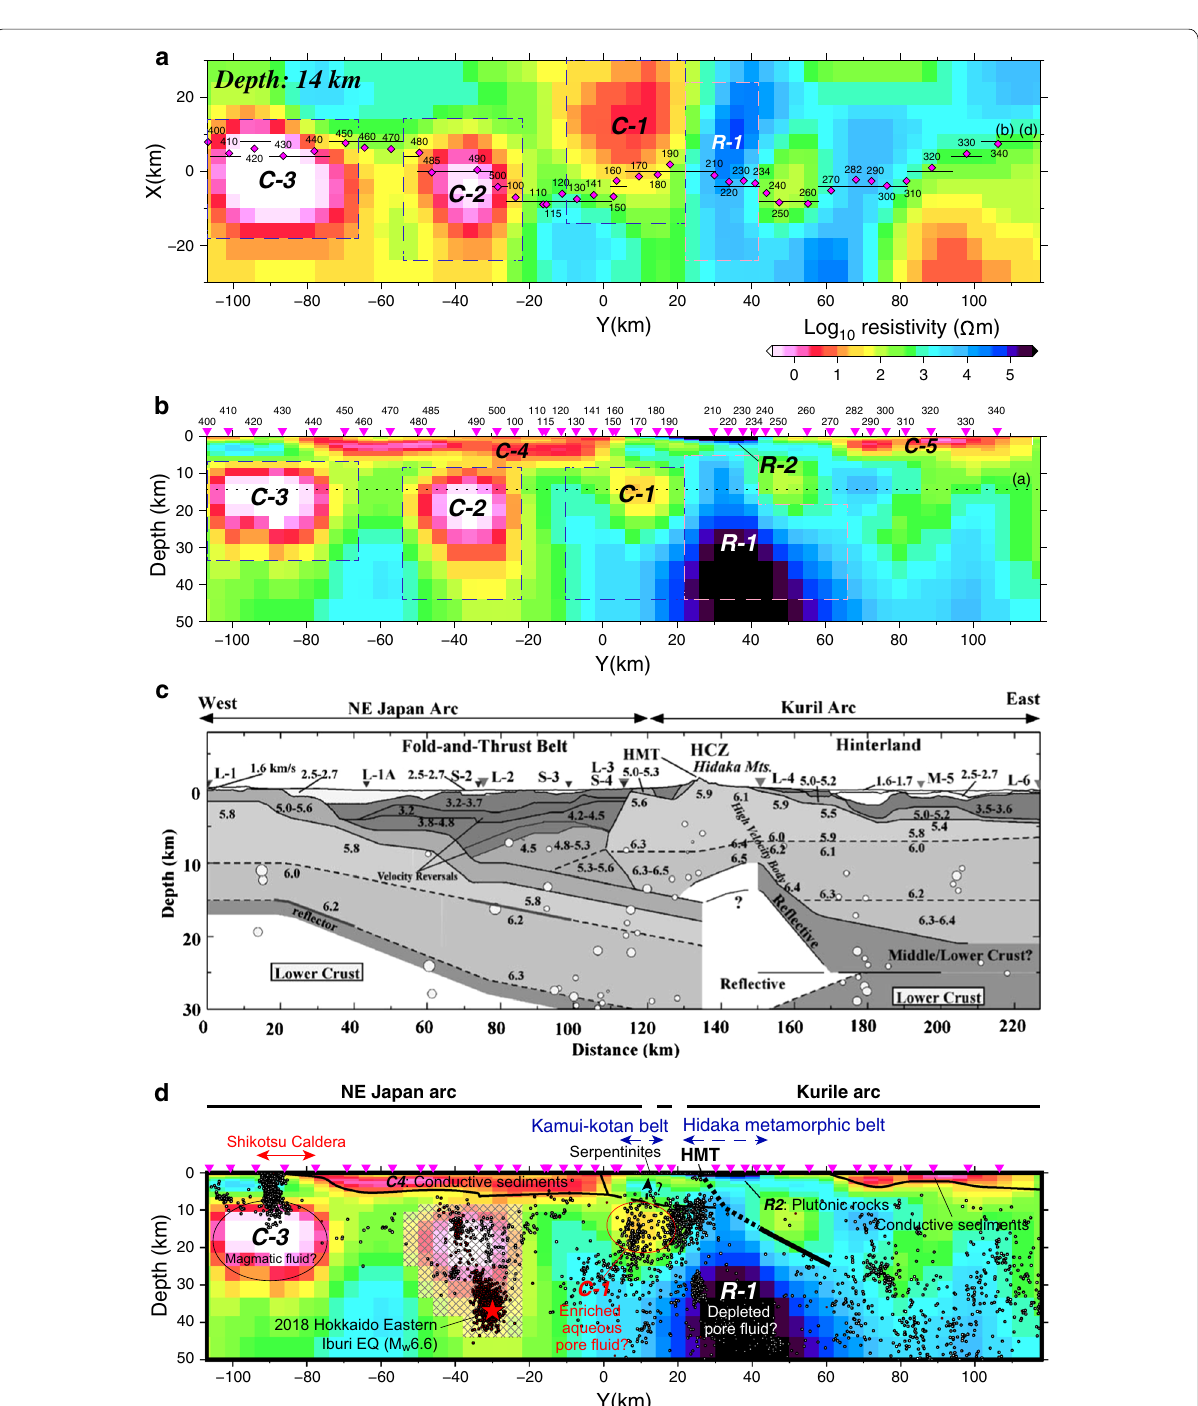
Fig. 4 Interpreted 3-D resistivity model. a Horizontal section of the inverted resistivity model at 14 km depth. Dashed lines show areas of sensitivity tests (where resistivity values were replaced). b Vertical cross-section beneath an east–west line around MT stations assembled from short east– west profiles shown as solid lines in a . Dotted line marks the horizontal position of a . c Interpreted seismic velocity section (from Iwasaki et al. 2004). The location of the seismic survey line corresponds closely to that of the MT survey line of this study. d Interpretations superimposed on the vertical cross-section of b . The red star denotes the hypocenter of the 2018 Hokkaido Eastern Iburi earthquake ( M w 6.6). The small circles denote hypocenters of earthquakes between 2001 and 2019. The red circles indicate hypocenters occurred after the 2018 Hokkaido Eastern Iburi earthquake. All hypocenters were determined by the Japan Meteorological Agency (2019). The C-2 is masked because of the low